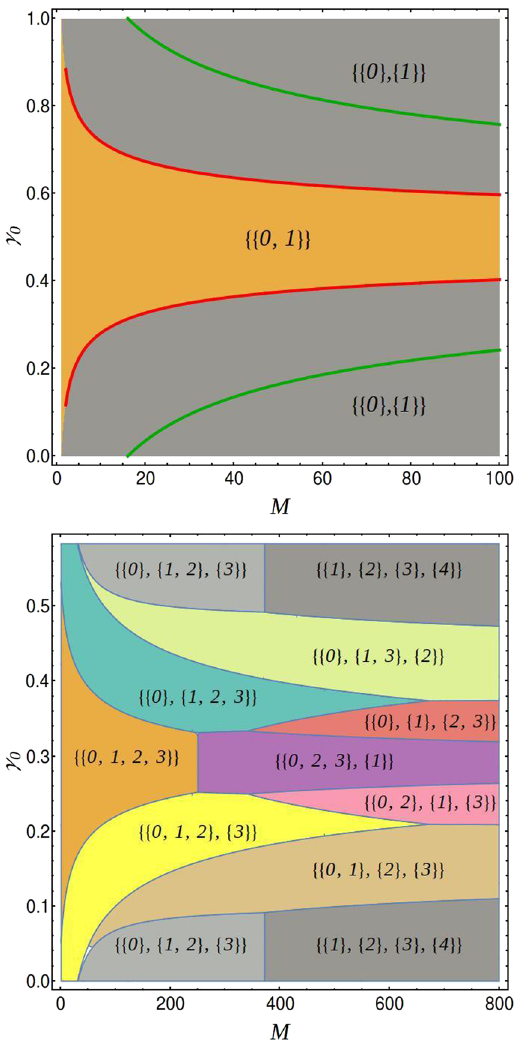
Figure 2. Comparison with NIST Suite test. Comparison of the bias allowed on a given sequence for it to be considered random using the NIST suite (upper panel) and our Bayesian method for randomness characterisation (lower